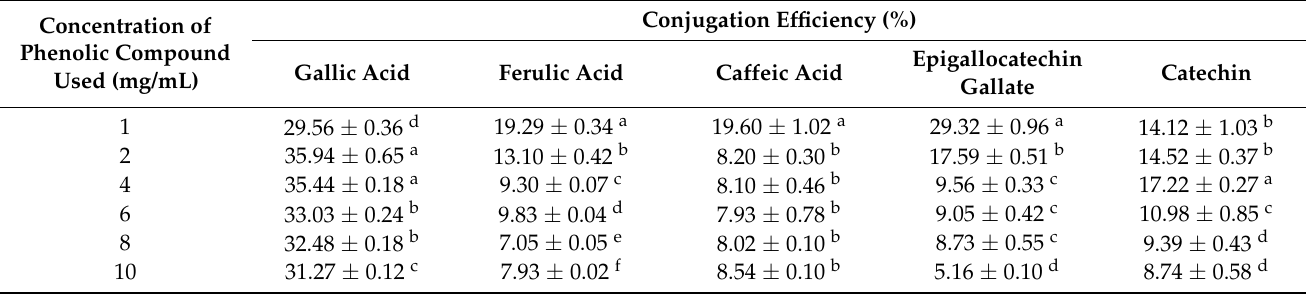
Table 1. Conjugation efficiency of different phenolic compounds at various concentrations conjugated on chitooligosaccharide.